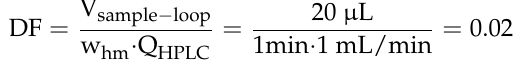
Figure 12. HPLC chromatogram of 125 mg/mL glucose and 115 mg/mL xylitol in ultrapure water, eluent 75% acetonitrile, 25% ultrapure water at 30 ◦ C, measured with CaSRR (blue) at 740 MHz (inflection point) and refractive index detector